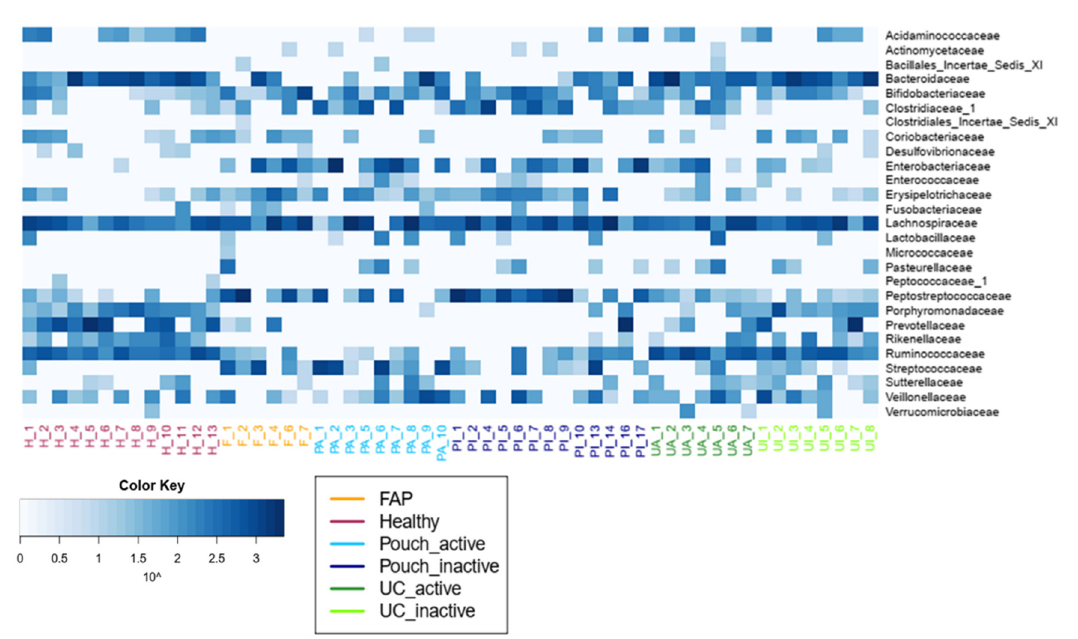
Figure 3. Family level diversity heat map. Bacterial abundances and differences in the abundance of bacterial families between groups are presented in Table S4a and Table S4b, respectively. Sample sizes were 6, 13, 9, 13, 7 and 8 for FAP, Healthy, Pouch active, Pouch inactive, UC active and UC inactive groups, respectively. Abbreviations: H—Healthy, F—FAP, PA—Pouch active, PI—Pouch inactive, UA—UC active, UI—UC inactive.